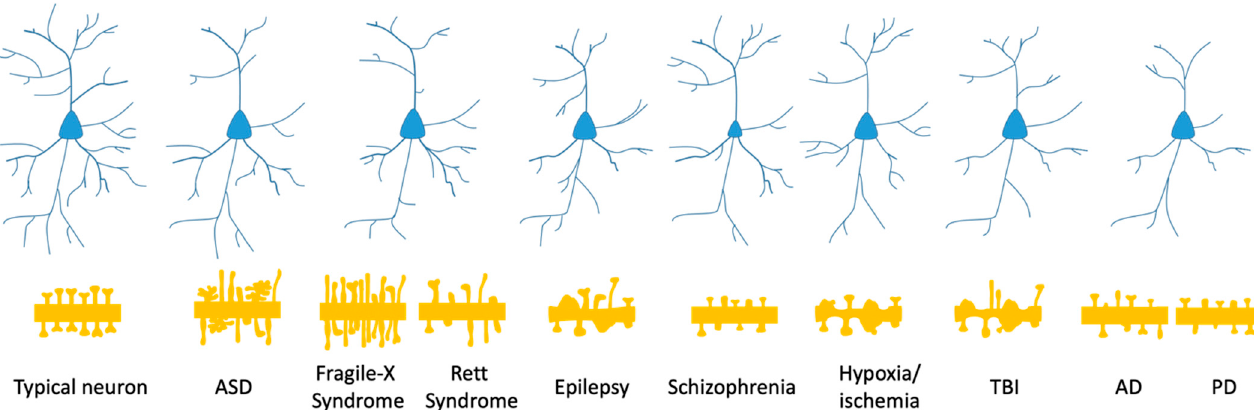
Figure 1. Schematic diagram summarising disease associated alterations in dendritic arborisation and spine formation. A neurotypical neuron elaborates complex branching and long and numerous dendrites. It also develops relatively stable and mature spines. Individuals with ASD often show reduced dendritic branching complexity and increased presence of immature/thorny spines and increased spine density. Neurons from fragile X and Rett syndrome patients have been found to display shorter and less abundant dendrites and abnormally long and thin spines of increased density. In patients with epilepsy, neurons have been observed to form shorter and less branched arbours that often display varicosities and distorted spines, and spine density is also decreased. Neurons from schizophrenic individuals display decreased spine size and abnormal spine necks, smaller somas, and a reduced number of dendrites. In subjects with hypoxia/ischemia or TBI, neurons elaborated less and shorter dendrites, with varicosities and constrictions, and showed reduced spine density and presence of abnormal spines. Decreased dendritic length and branching as well as spine loss has been observed in neurons from patients with AD and PD. AD—Alzheimer’s disease, ASD—autism spectrum disorder, PD—Parkinson’s disease, TBI—traumatic brain